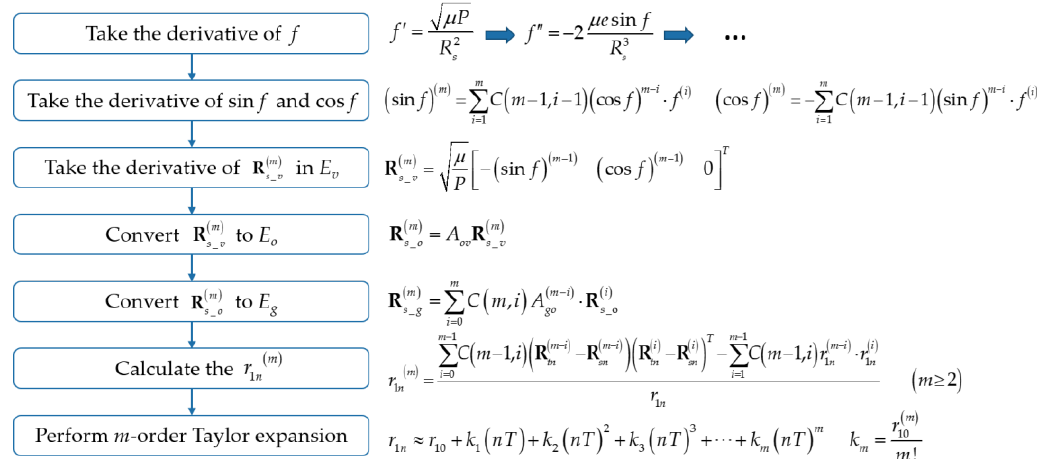
Figure 8. The propagation history of transmitting and receiving pulse at the n th PRT. P is a point target on the earth. r 1 n , r 2 n represent the transmitting distance vector and receiving distance vector, respectively.  n is the total propagation time of the pulse. The relationship between pulse transmitting distance and receiving distance can be expressed as: